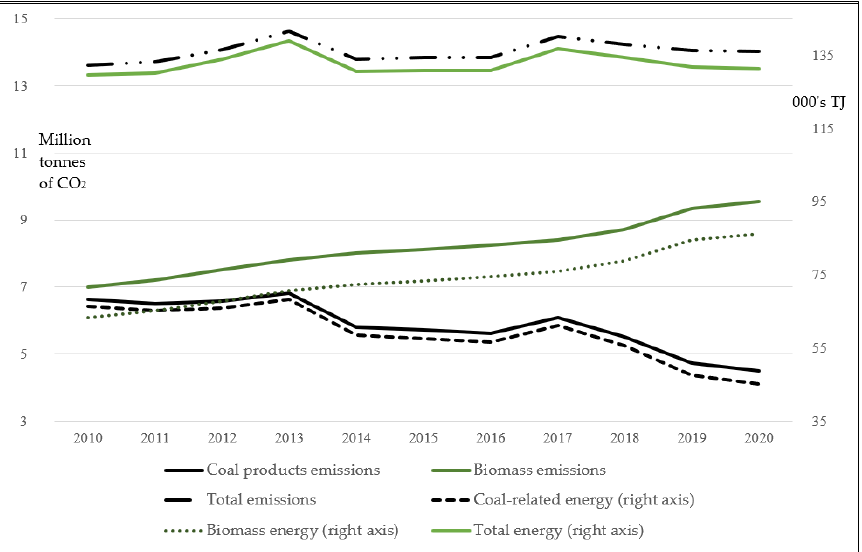
Figure 1. Emissions and energy obtained (various fuels, 2010–2020, Czech households). Source: authors’ calculations based on the data reported in [60,61,67].